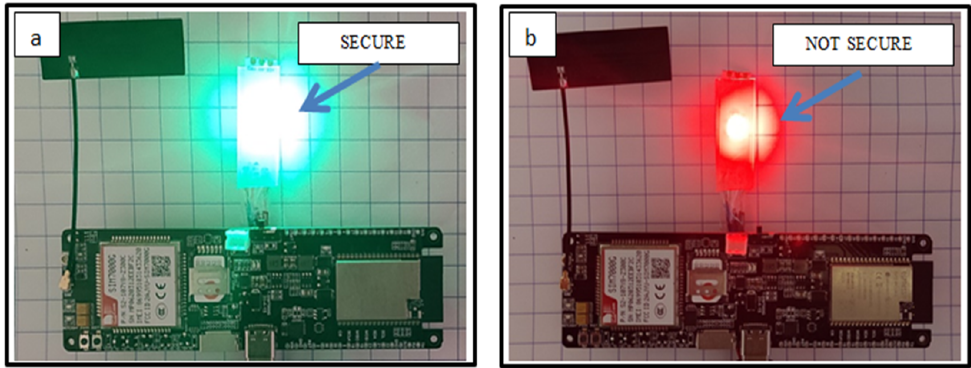
Figure 11. Experimental digital signage. ( a ) SECURE; ( b ) NOT SECURE .